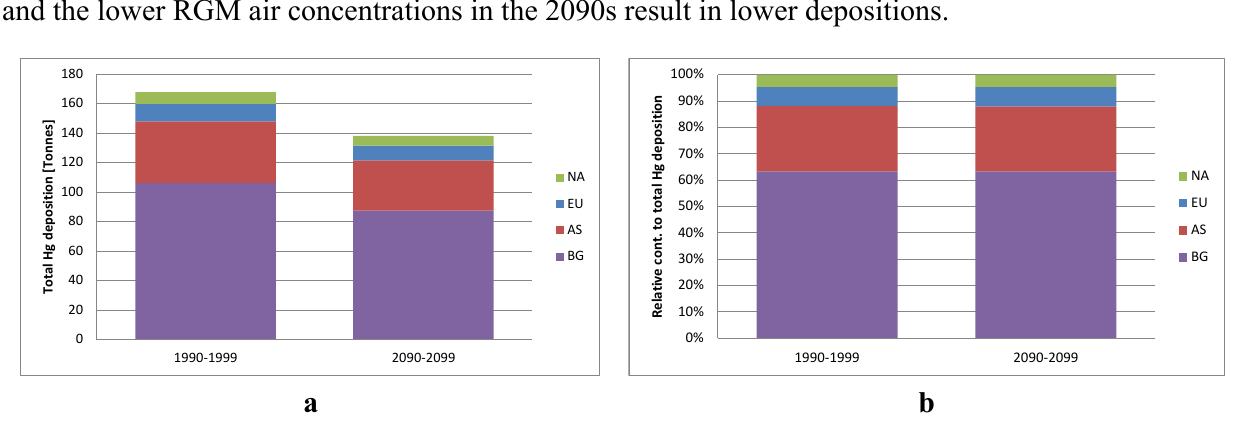
Figure 3. The total deposition of Hg in tons/year with the contribution from the different source areas including indirect contribution ( a ) and the relative contribution from the different source areas to the total deposition of Hg for the Arctic ( b ) for the two studied